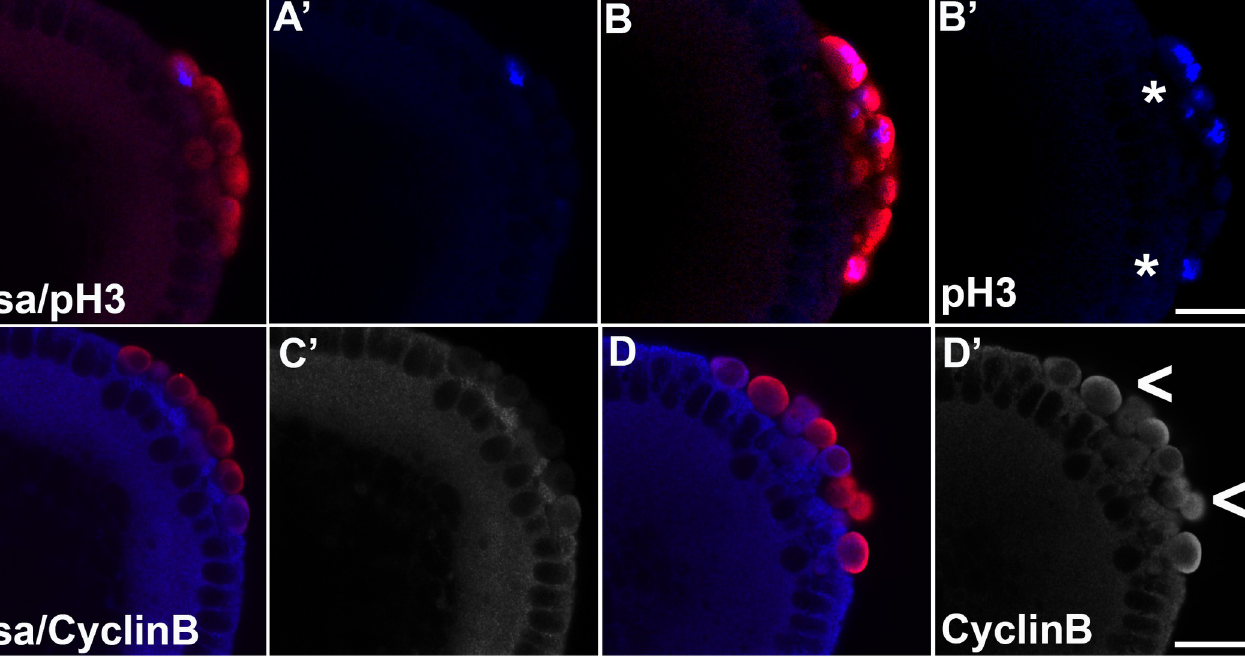
PLOS Genetics | https://doi.org/10.1371/journal.pgen.1010002 January5,